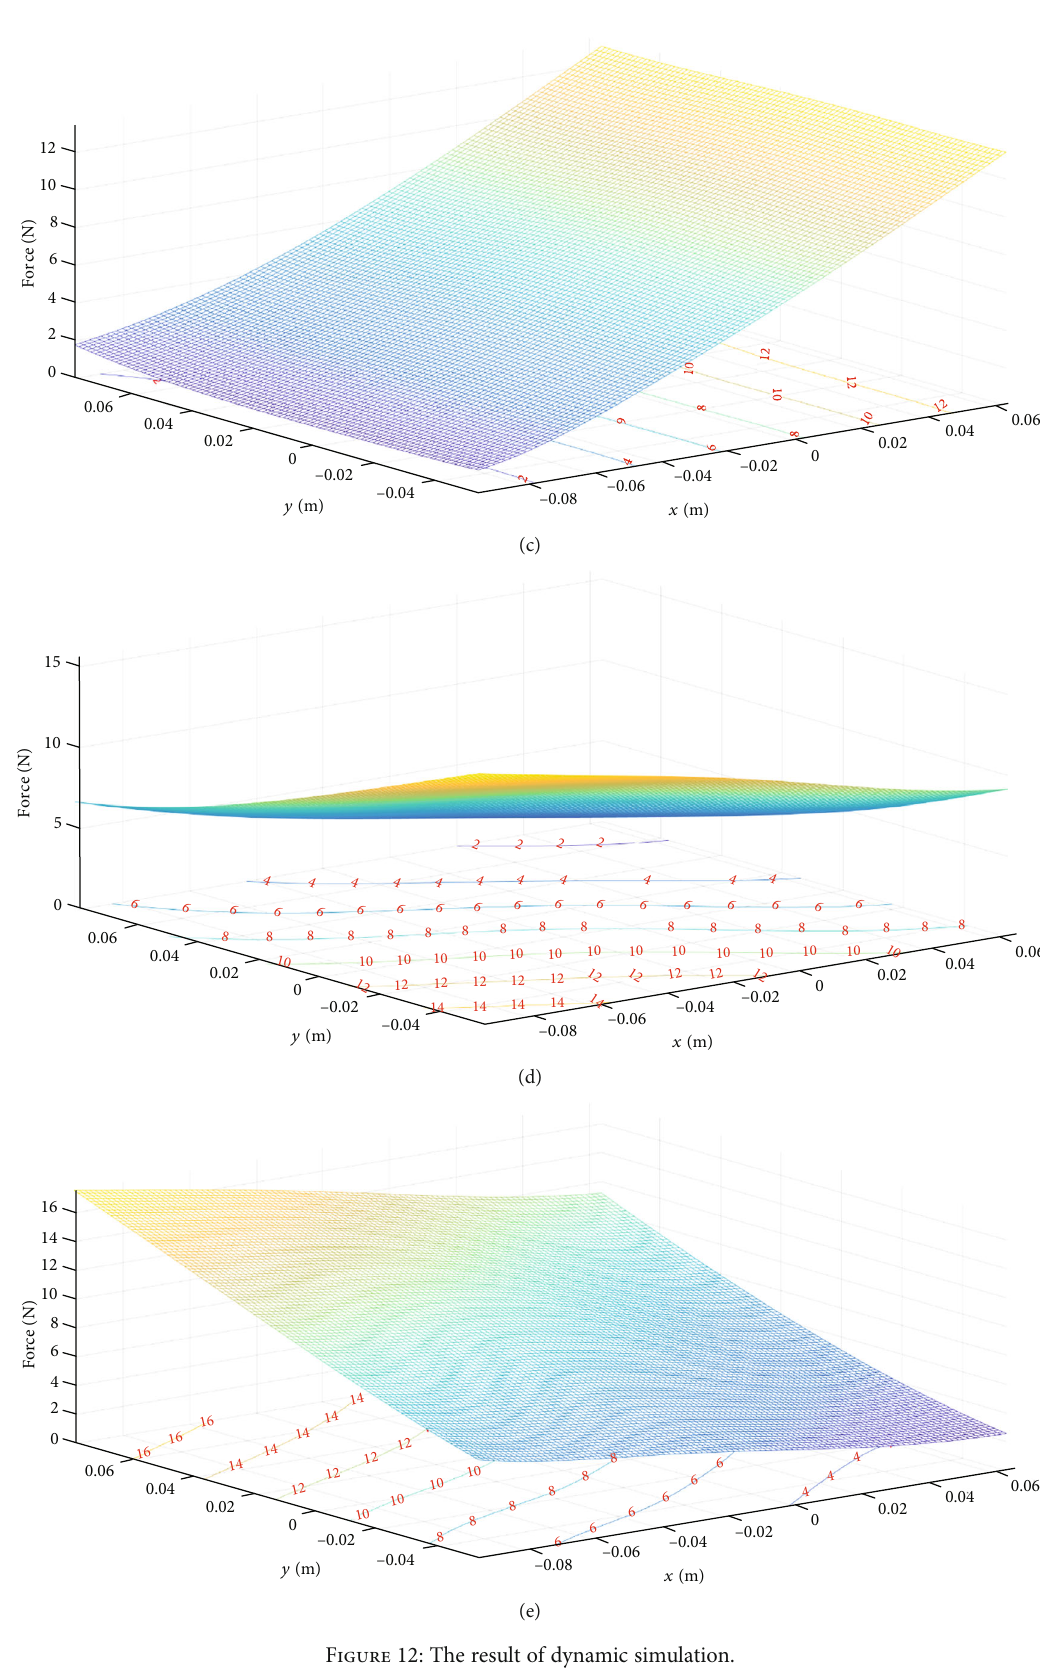
Figure 12: The result of dynamic